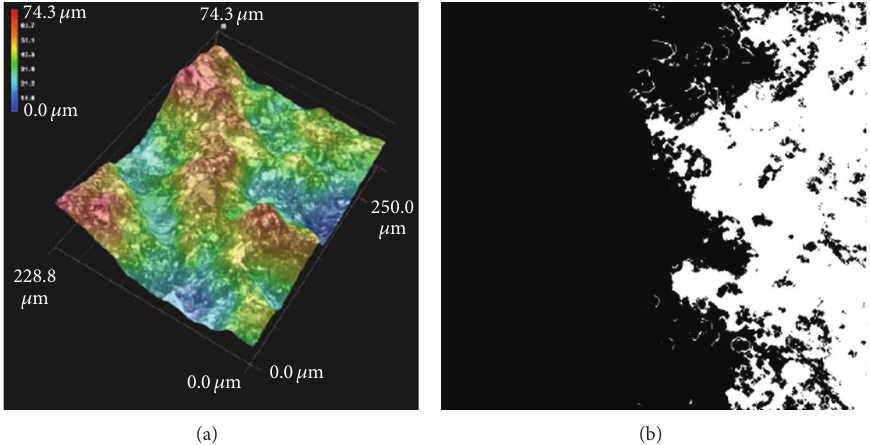
Figure 2: (a) 3D image of typical fractured surface at 1000 times magnification and (b) closed-contour at 10 𝜇 m depth [11].